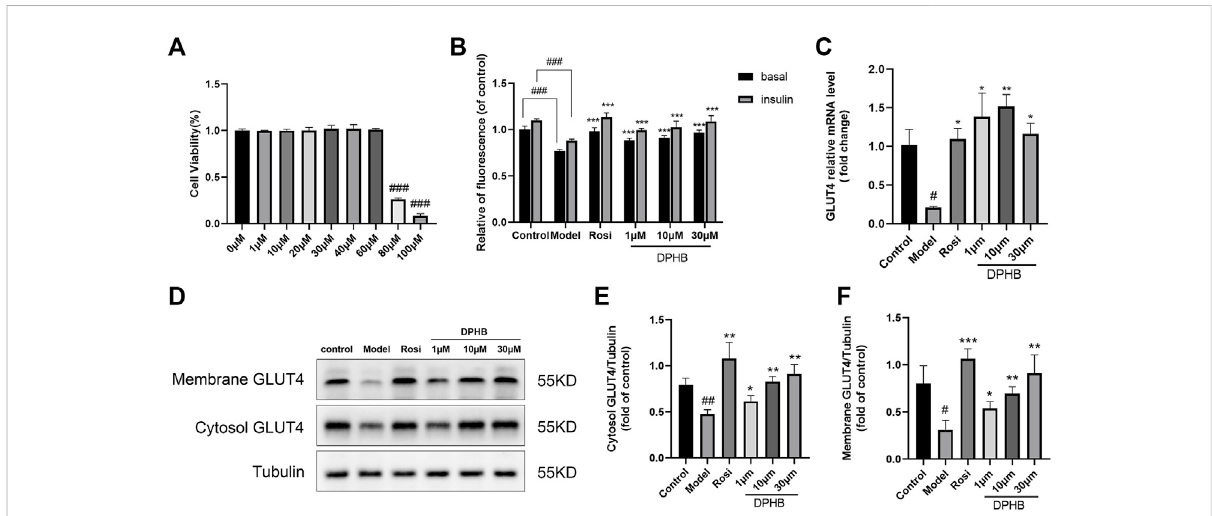
FIGURE 4 Effects of DPHB on glucose metabolism in IR-3T3-L1 adipocytes. (A) Effect of different concentrations of DPHB on the viability of 3T3-L1 adipocytesfor16h; (B) quantifying fl uorescencedeterminedtheextentofglucoseuptake; (C) mRNAexpressionofGLUT4; (D) proteinexpressionof GLUT4; (E) quanti fi cation of cytosol GLUT4; (F) quanti fi cation of membrane GLUT4. All values are expressed as the means ± SD, ( n ≥ 3). * p < 0.05, ** p < 0.01, and *** p < 0.001, when compared with the model control group; and # p < 0.05, ## p < 0.01, and ### p < 0.001, when compared with the control